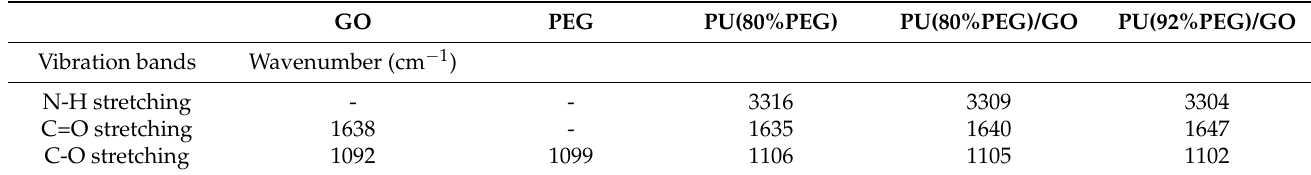
Figure 2. ( a ) XRD patterns of PEG, PU and PU/GO; ( b ) FT-IR spectra of PEG, PU and PU/GO. Table 2. The detailed compositions of the FT-IR spectra .